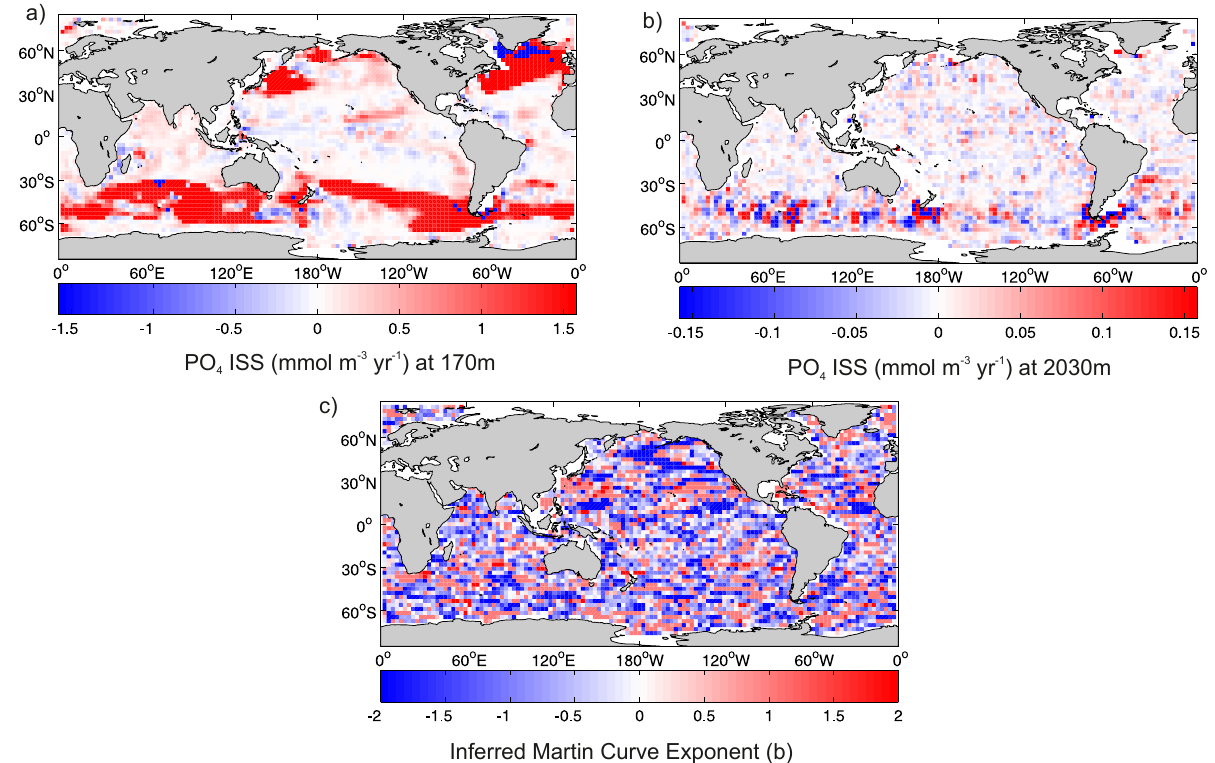
Figure 2. Example of using a GCM transport matrix to estimate PO 4 remineralisation rates. (a) The estimated PO 4 remineralisation rates generated using the MITgcm transport matrix at 170 and (b) 2030m. (c) Power-law flux curve exponents (b) inferred from the estimated remineralisation rates by fitting a linear function to the log-transformed data as in Fig.